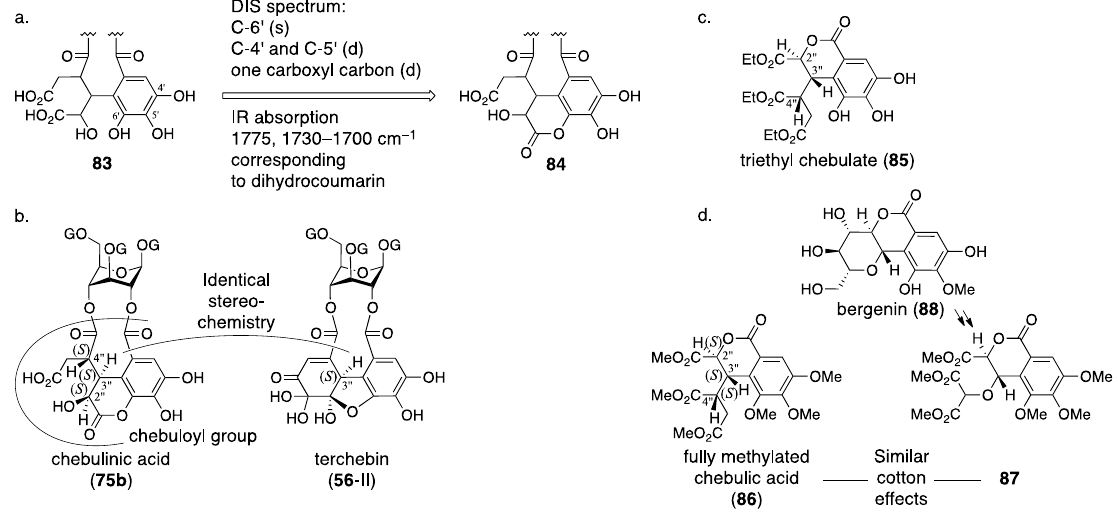
Figure 33. The structural revision of the chebuloyl group for the latest structures of chebulinic acid ( 75b ) and chebulagic acid ( 77b ). DIS, differential isotope